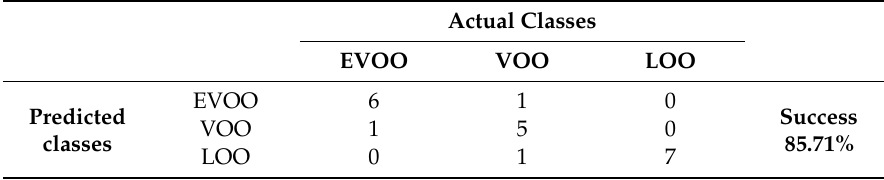
Table 5. Validation matrix by k-NN using the TIC obtained with HS-GC-MS.